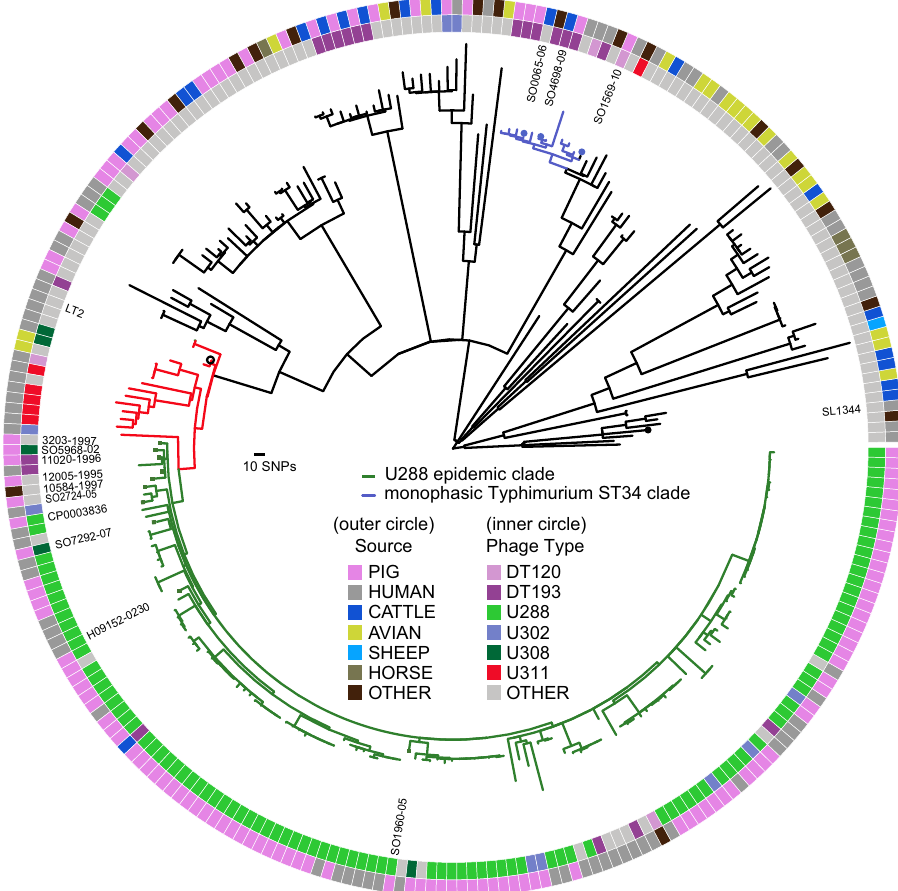
Fig. 2 Phylogenetic relationship of S . Typhimurium U288 and S . 4,[5],12:i:- epidemic clades in the context of S . Typhimurium diversity. Mid-point rooted maximum likelihood phylogenetic tree constructed using 7189 SNPs from the recombination-purged core genome sequence of 262 S . Typhimurium isolates: 79 U288 strains isolated from animals in the UK in the years 2014 and 2015, 36 human clinical strains from the main U288 clade isolated from 2014 and 2015, a U288 isolate (CP0003836), reported previously from Denmark in 2016, 32 131 isolates from the UK that represented diverse phage types, 12 and 15 closely related but non-U288-clade isolates. The source of isolate (outer circle) and phage-type of isolate (inner circle) are speci fi ed by the fi ll colour as indicated in the key. S . Typhimurium U288 (green lineages), closely related to U288 (red lineages) and monophasic S . Typhimurium ST34 (blue lineages) are indicated.